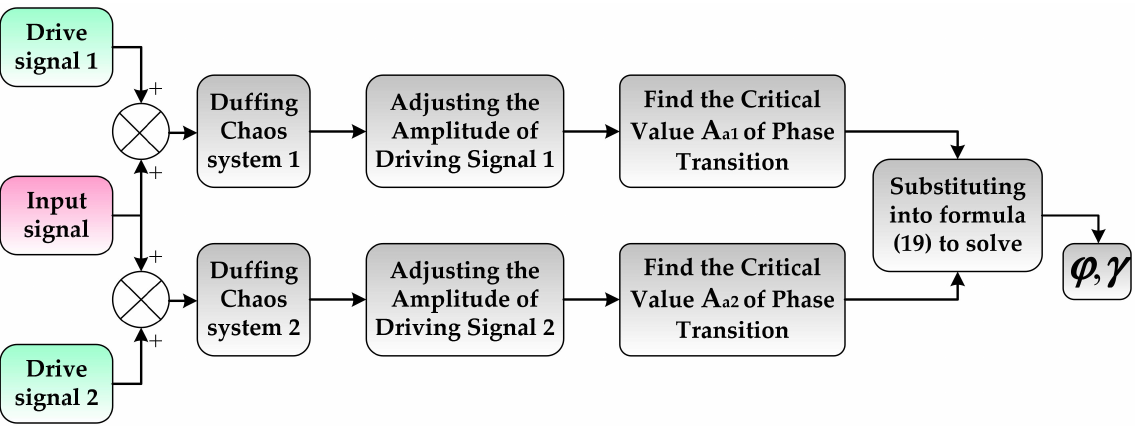
Figure 3. The synchronization estimation model of the amplitude and phase parameters for